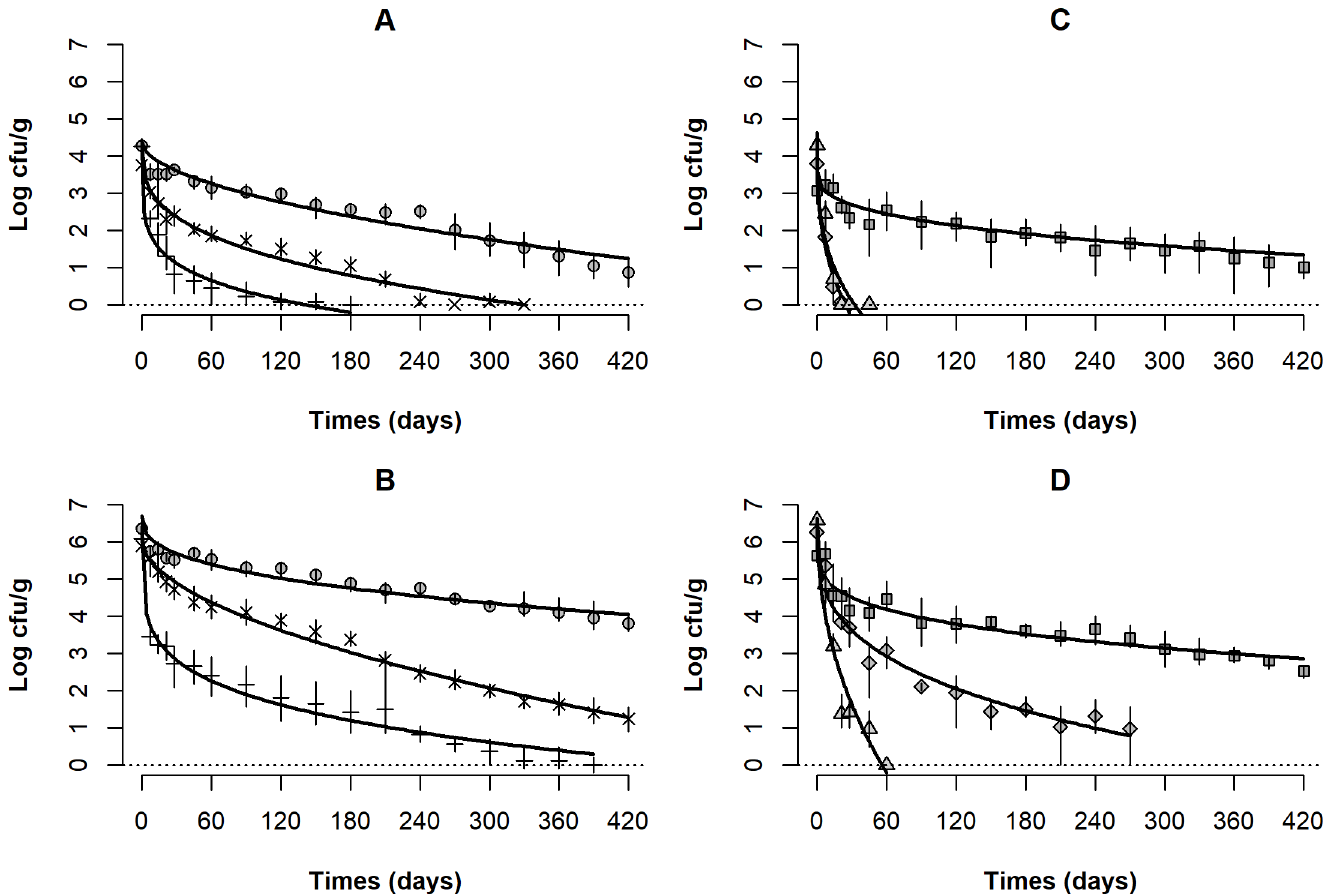
Fig 2. Salmonella Typhimurium ATCC 14028 survival curve artificially inoculated in peanut products stored at 28 ± 1˚ C. Low inoculum level 3 log cfu/ g (A and C). High inoculum level 6 log cfu/ g (B and D). Raw in-shell peanuts (+), roasted peanuts ( ● ), unblanched peanut kernels ( × ), peanut brittle ( ♦ ), paçoca ( ■ ), pé-de- moça ( ▲ ).The dotted line represents the limit of detection for Salmonella of 0 log cfu/ g or 1 cfu/ g.